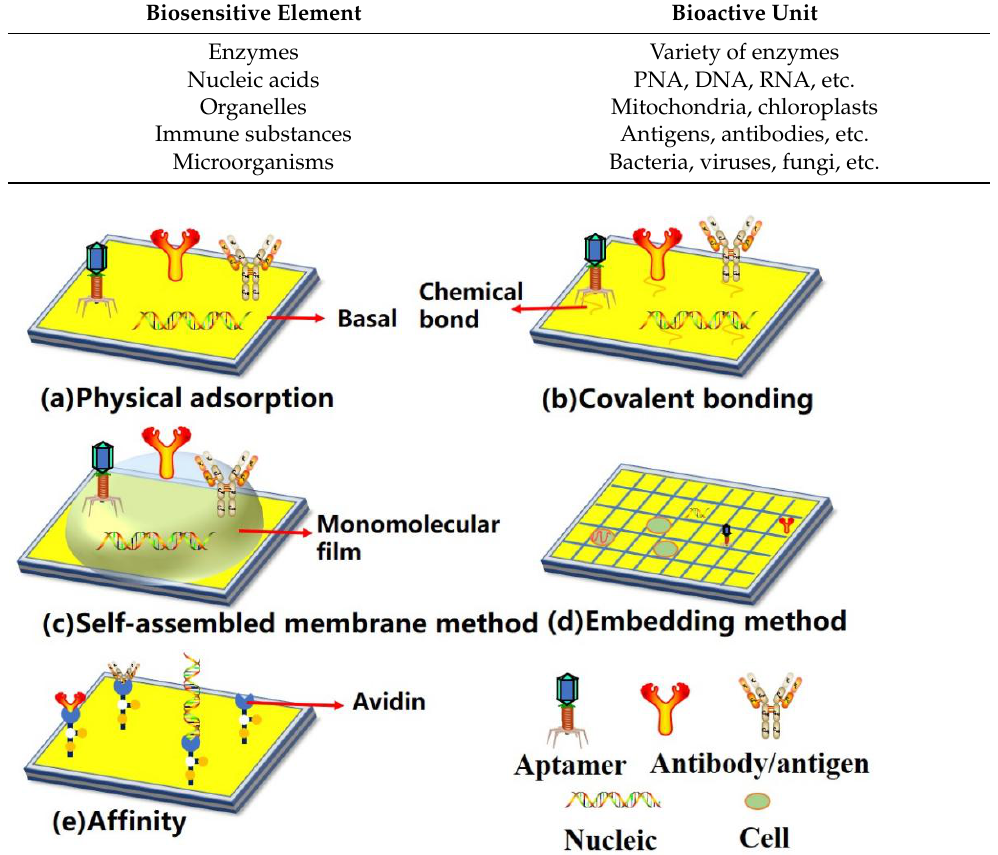
Figure 2. Schematic diagram of sensing surface structure. Biomolecular receptors can be fixed on the surface of a biosensor by ( a ) physical adsorption, ( b ) covalent bonding, ( c ) self-assembled membrane method, ( d ) embedding method, and ( e ) affinity. Table 1. Biomolecular recognition devices.